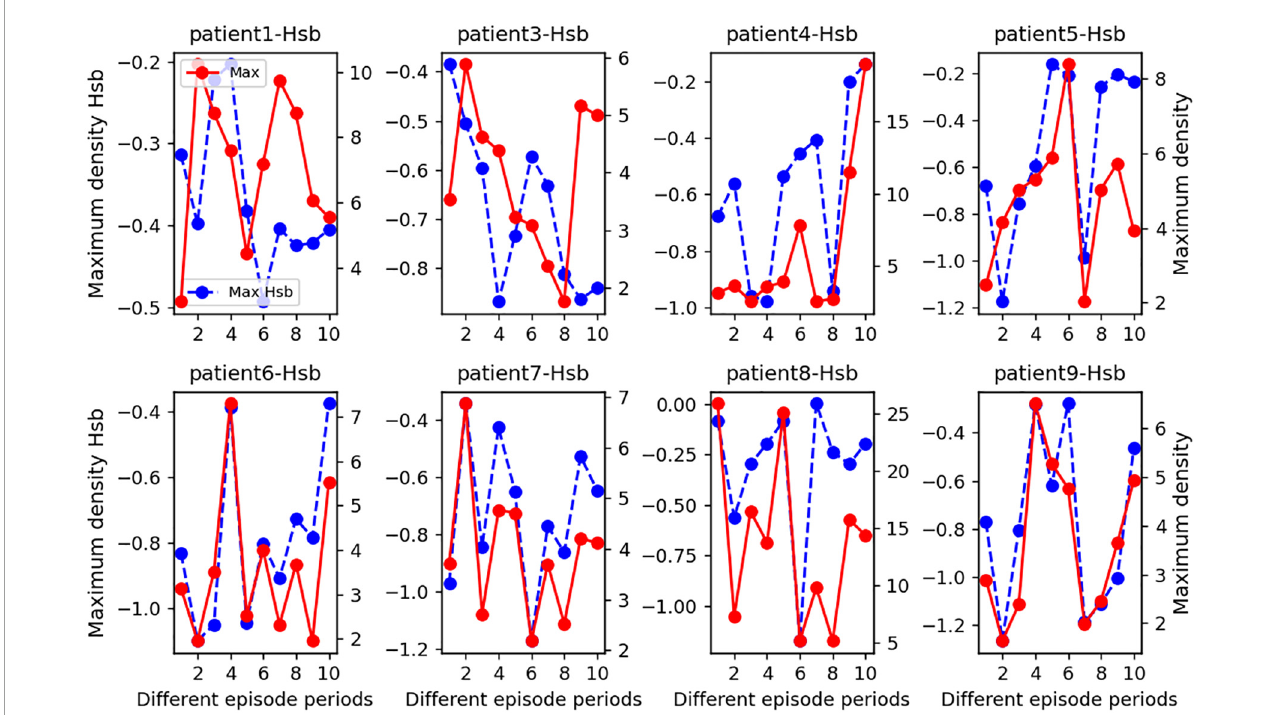
FIGURE6 A statistical line chart of the maximal H sb nucleus density for seizure durations in eight epileptic individuals. On average, we subdivided each seizure phase into two sections and chose two interictal intervals to examine. Specifically, the x-axis values of each subplot represent several seizure periods: 0–2 for the interictal period 1, 2–4 for the interictal period 2, 4–6 for the pre-ictal period, 6–8 for the seizure period, and 9–10 for the post-ictal period. In addition, we counted the peaks in the H sb nucleus density distribution plot during each phase and recorded the H sb values corresponding to the peaks together with the density values to create this line graph. The patient number is the title of each subplot, the blue dashed line represents the magnitude of the maximum density of H sb values for each time interval, as measured by the left y-axis, and the solid red line represents the maximum density value for each time interval, as measured by the right